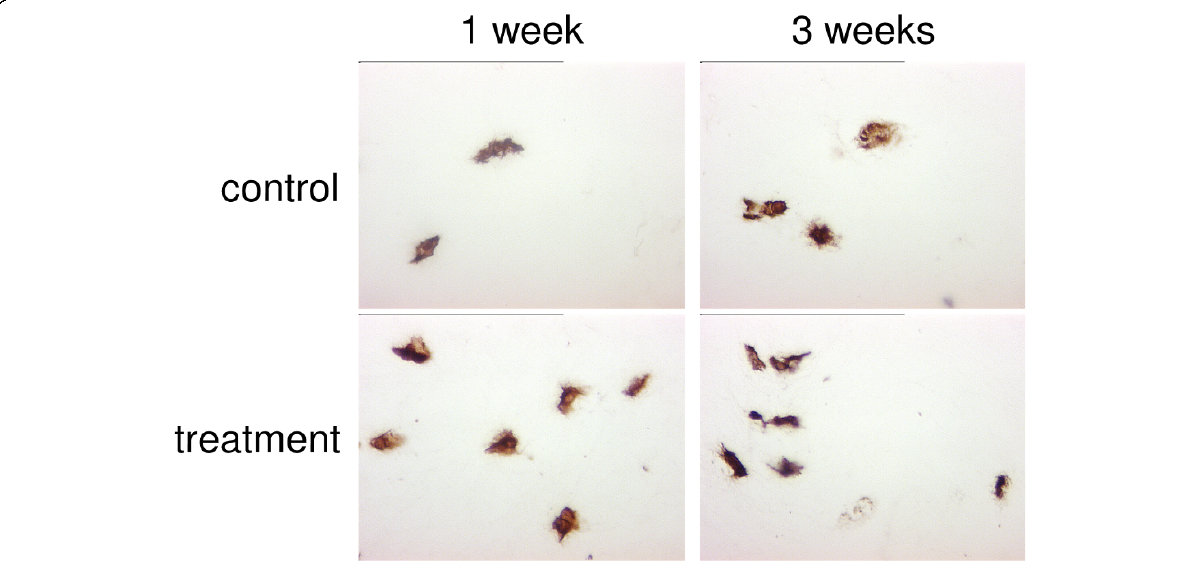
Figure 3 Collagen type-II immunostaining of in-vitro cultivated specimens . Immunohistological staining of collagen type-II protein in cell- seeded collagen gel samples left untreated or stimulated by millicurrent treatment after 1 and 3 weeks of in-vitro cultivation. Collagen type-II was detected mainly pericellularely. Original magnification ×630.